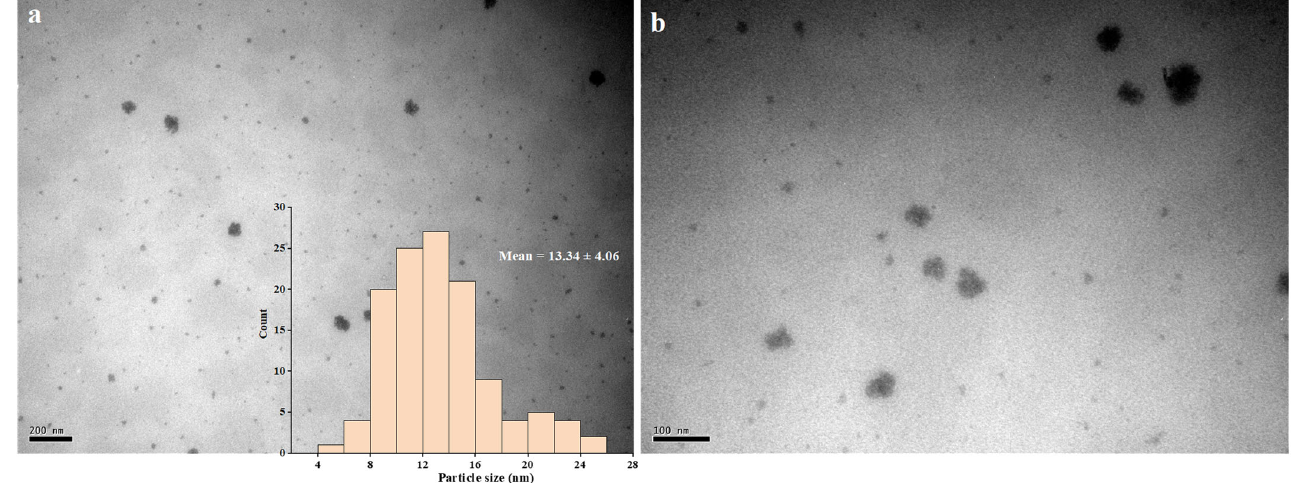
Figure 6. TEM images of PtNPs: ( a ) the field of view at 200 nm; ( b ) the field of view at 10 nm.